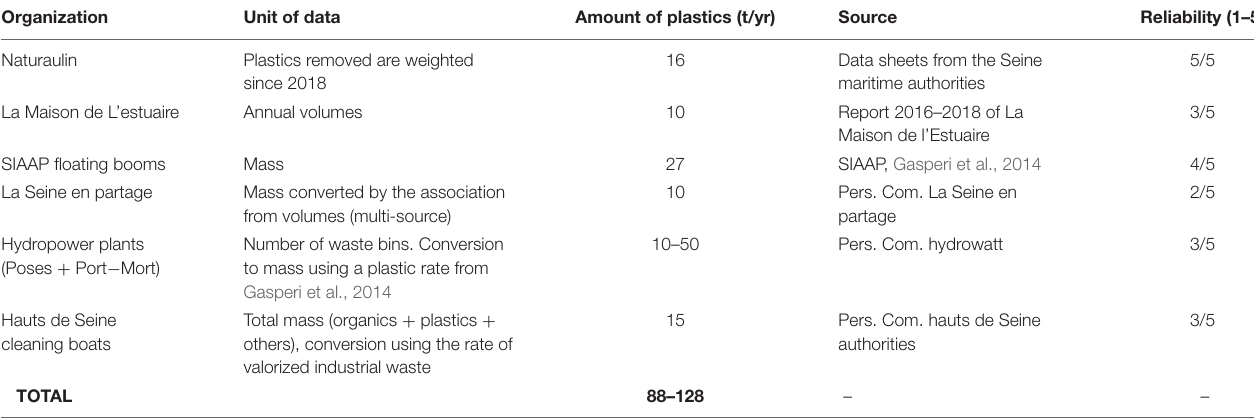
TABLE 1 | Estimates of plastic amounts collected in the Seine river or on river banks.